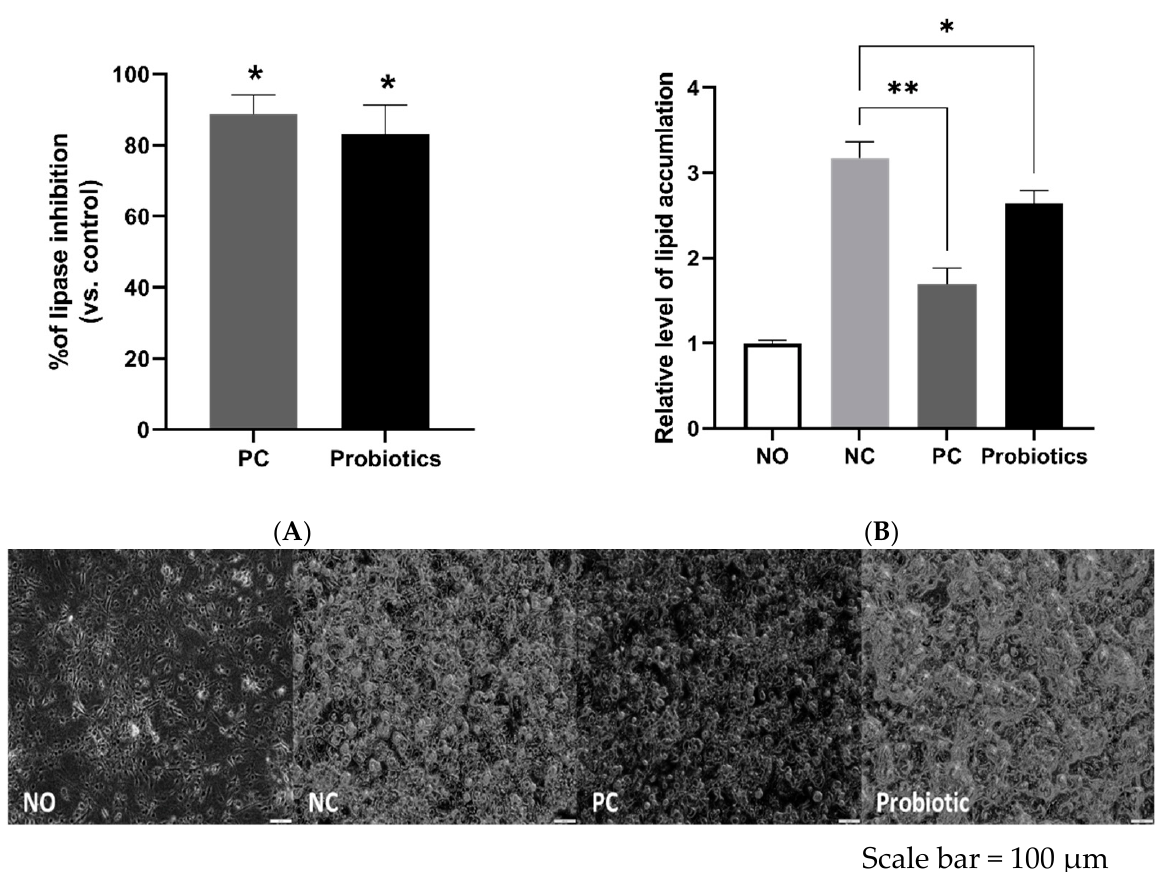
Figure 1. Inhibitory effect of multi-strain probiotics (MSPs) on lipid accumulation in vitro. ( A ) Relative inhibition of lipase activity (%). ( B ) Relative level of lipid content in 3T3-L1 cells. ( C ) Representative images of Oil Red O staining of 3T3-L1 cells in different groups (scale bar = 100 µm). Data are expressed as mean ± standard deviation. * p < 0.05; ** p < 0.01 vs. negative control. NO, undifferentiated 3T3-L1 cells; NC, negative control; PC, orlistat-treated; Probiotics, MSPs-treated.